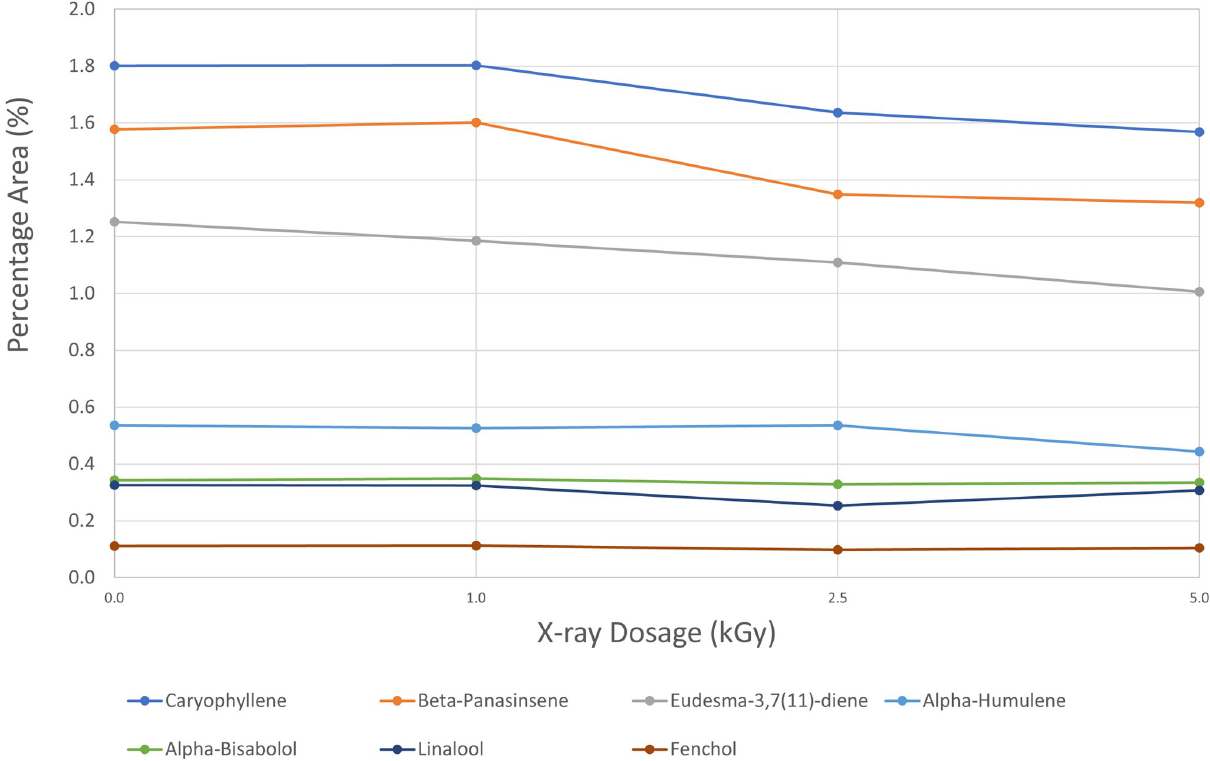
Fig 3. Qualitative terpenes profile changes in flower samples of untreated and treated at different X-ray irradiation dosage levels. % Peak Area = area percentage of each peak or compound found in instrument analysis. It only roughly represents composition and amounts present in the